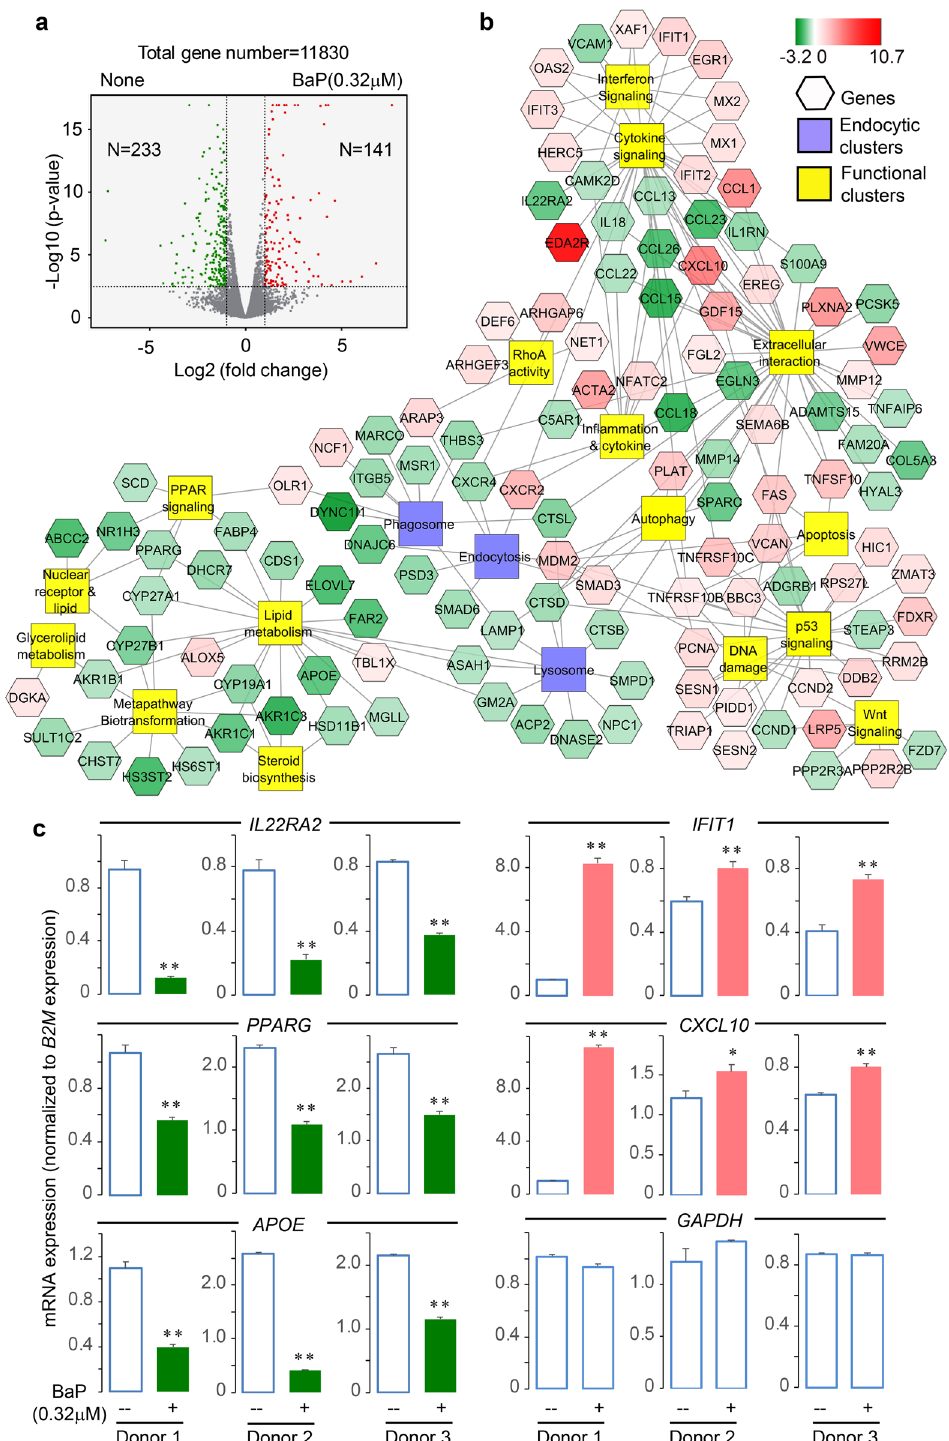
Figure 3. Altered gene expression profiles upon BaP exposure. Human monocyte-derived DCs from each donor (n = 3) were incubated with BaP and sorted for labeled conventional DCs, which were further used for RNA extraction and transcriptomic analysis. A volcano plot shows the number of differentially expressed genes (vertical lines = two-fold intensity difference, horizontal line = 0.05 false discovery rate-adjusted p-value) ( a ). The altered genes were clustered by functions ( b ). The expression level of some targeted genes was confirmed using RT-qPCR by normalization to B2M gene expression ( c ). Gene expression in BaP-exposed and non- exposed DCs was compared in three individual donors. The standard errors were calculated from triplicate reactions. The p-values were calculated using Student’s t-tests and are shown as ** (p < 0.01) or * (p <